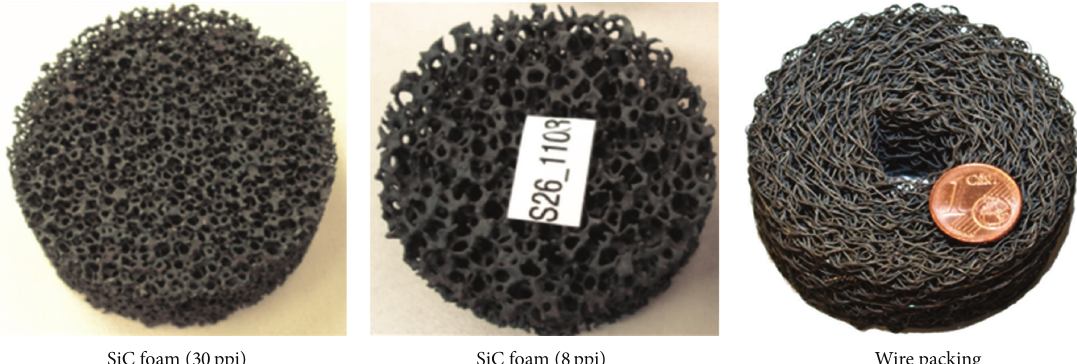
Figure 1: Examples of porous reactors used in the present investigation.